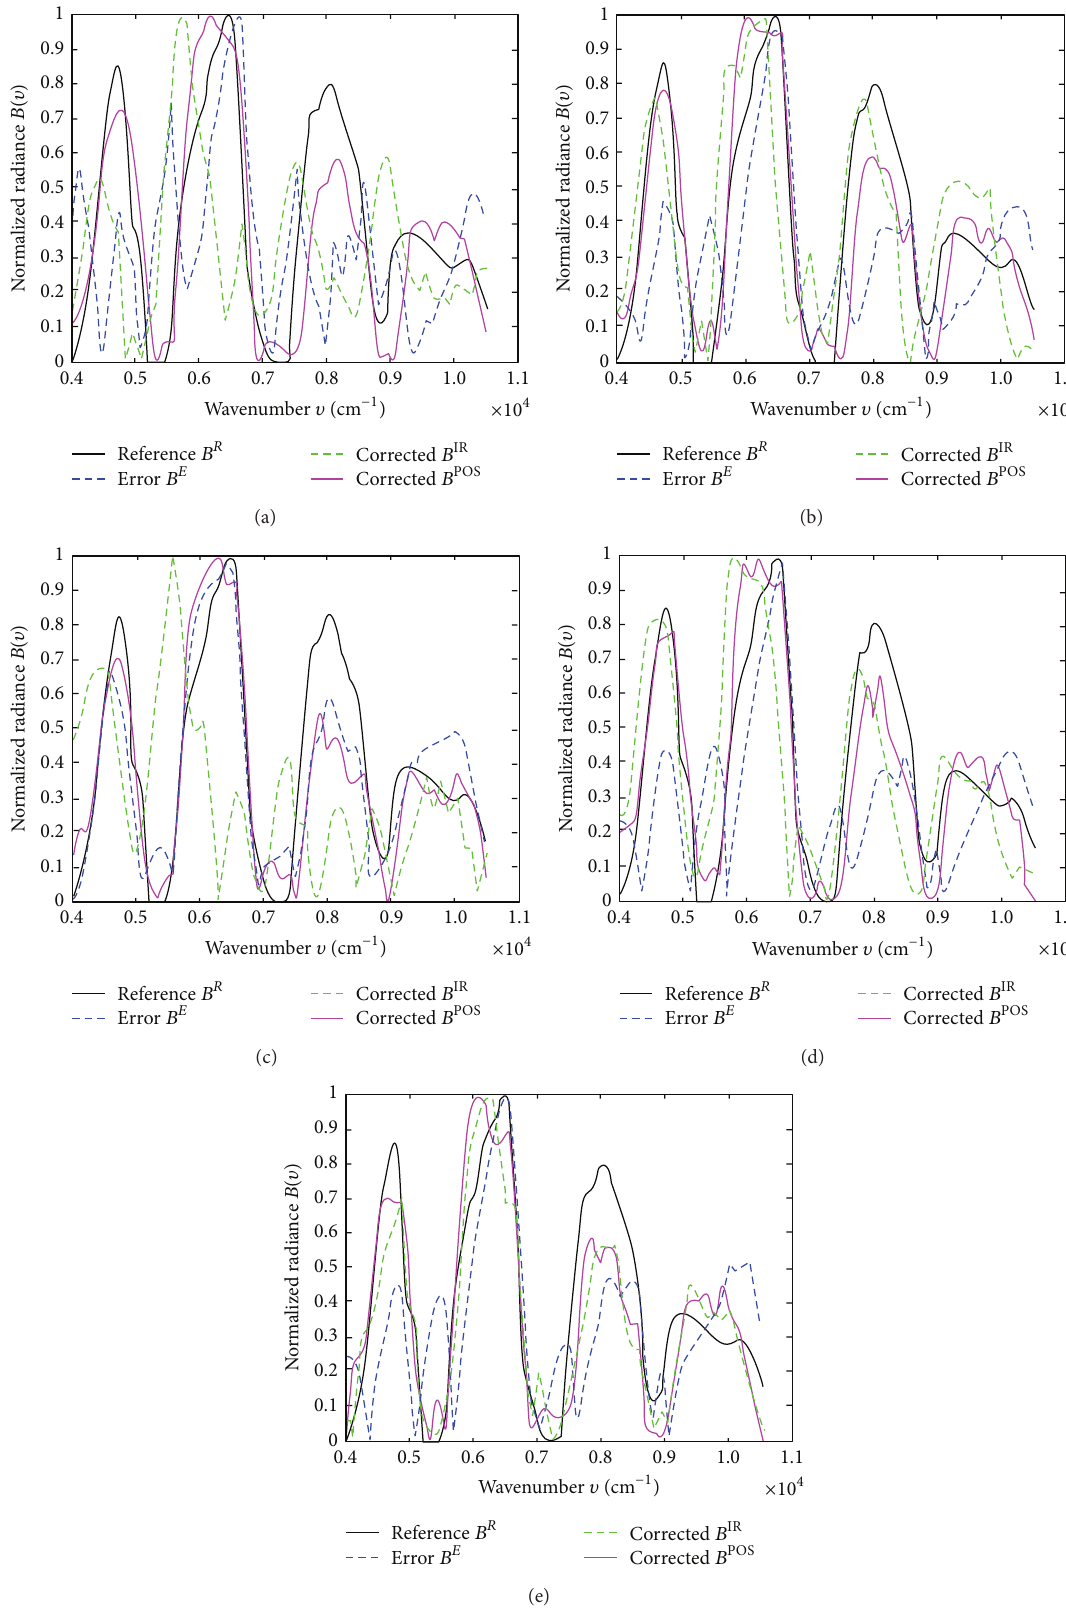
Figure 11: Five groups of the reconstructed